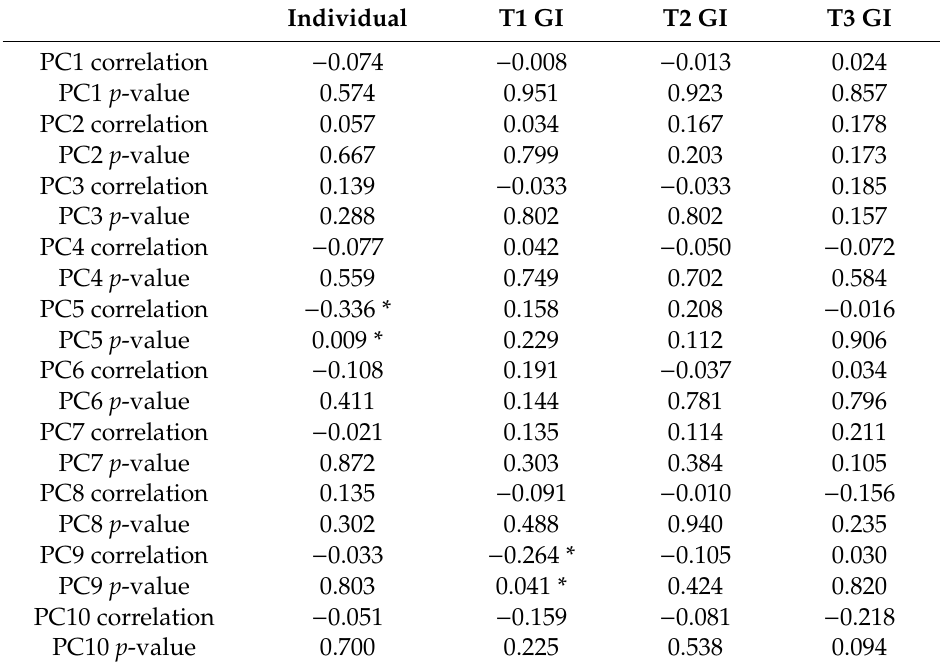
Table 4. Principle component analysis of dietary glycemic index during pregnancy and DNA methylation levels in five-year-old o ff spring ( n =